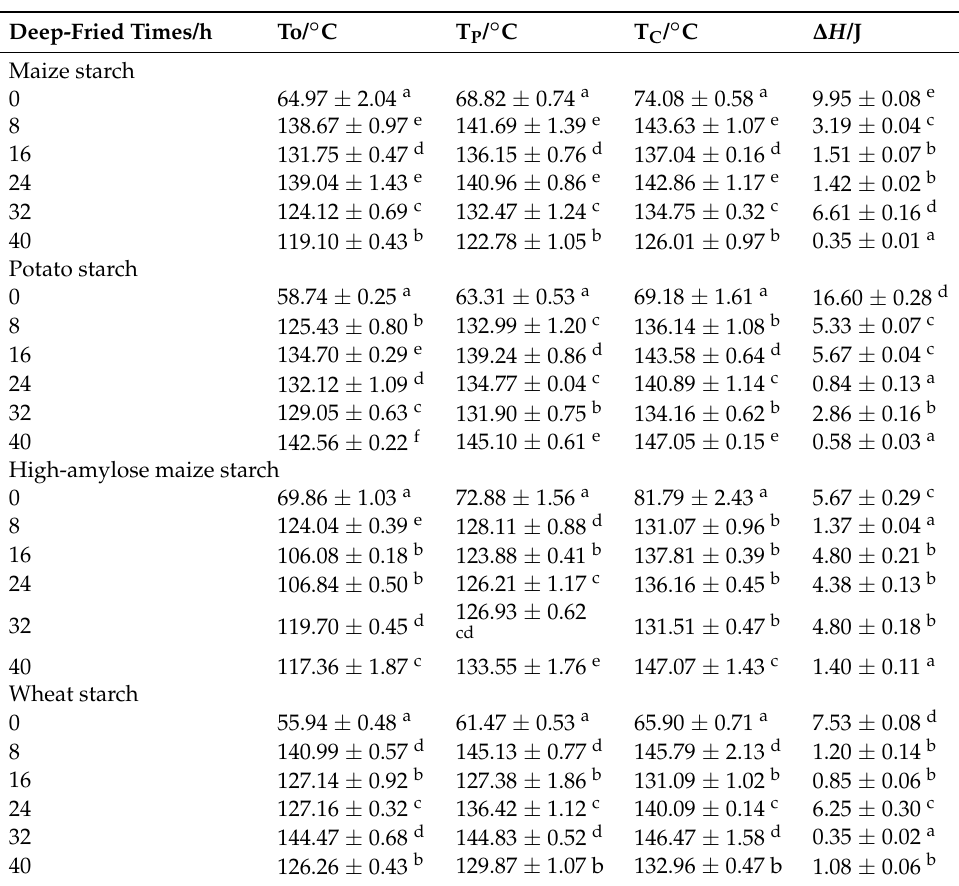
Table 1. Thermodynamic properties of starch during the deep-frying process. Deep-Fried Times/h